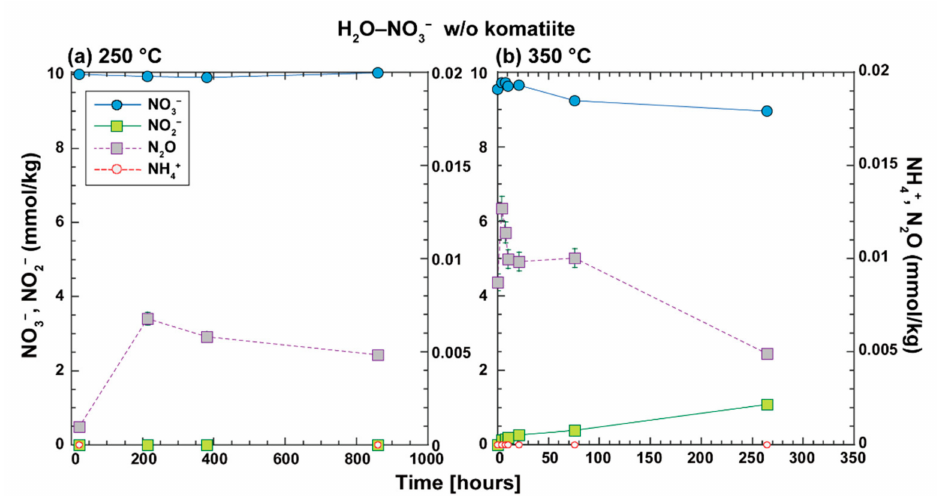
Figure 2. Mole fractions of nitrate, nitrite, nitrous oxide, and ammonia in aqueous fluids without komatiite at ( a ) 250 ◦ C and ( b ) 350 ◦ C. Measured concentrations of nitrogen species at a given time are normalized by the initial concentration of nitrate (10 mmol/kg) to estimate the mole fractions. For each plot, Y axis on the left side shows the scale of the mole fractions of nitrate and nitrite, whereas that on the right side shows the scale of the mole fractions of nitrous oxide and ammonia.